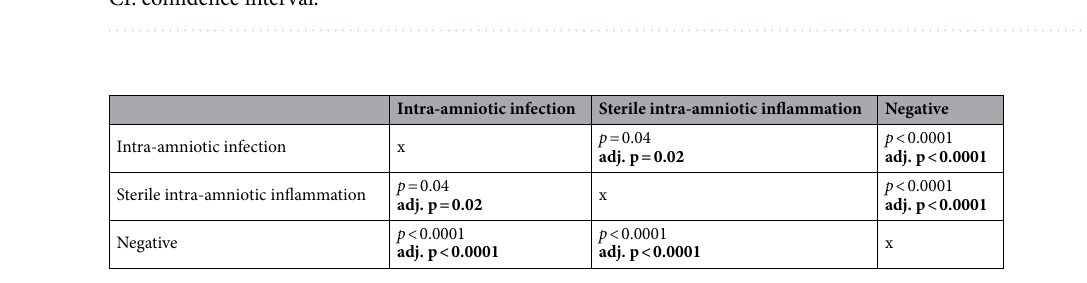
Table 6. IgGFc-binding protein in amniotic fluid from preterm labor with intact membranes: the comparisons among the subgroups of the women with intra-amniotic infection, sterile intra-amniotic inflammation, and negative amniotic fluid. p -value: a comparison between two subgroups (a nonparametric Mann–Whitney U test); Adj. p -value: a comparison between two subgroups after the adjustment for gestational age at sampling (a Spearman partial correlation). Statistically significant results are marked in